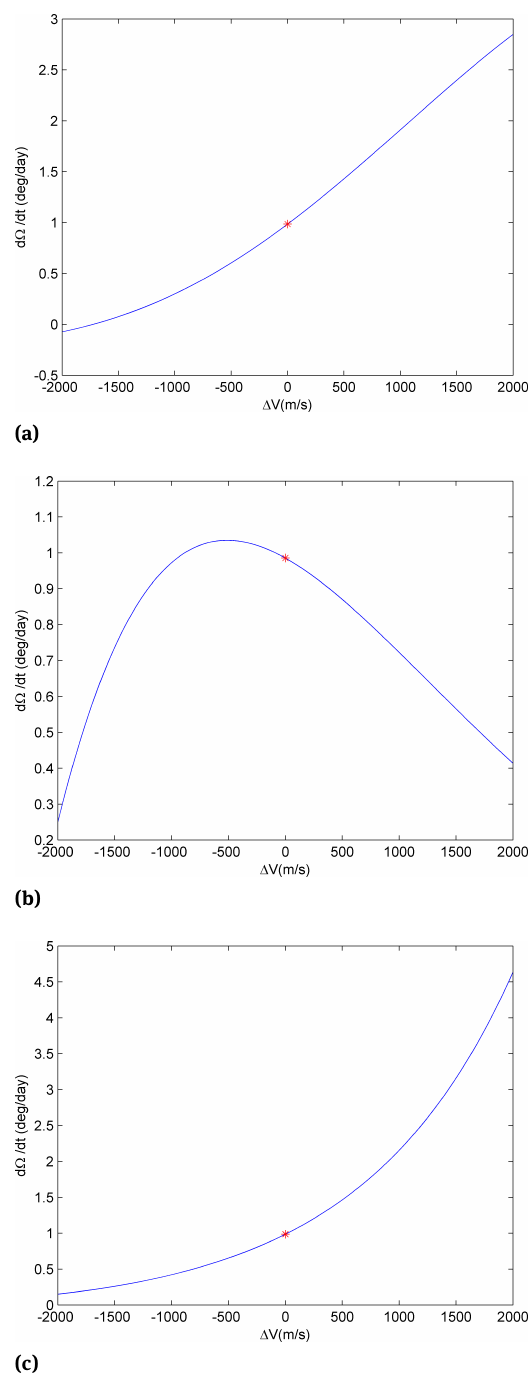
Figure 7. The relative relationship of the velocity error and the rate of change of the right ascension of the ascending node. The red point means that the rate of change of the right ascension of the ascending node equals 0.9856 deg/day when the velocity error is zero. (a) the velocity error is along the x axis of the inertial system; (a) the velocity error is along the y axis of the inertial system; (a) the velocity error is along the z axis of the inertial